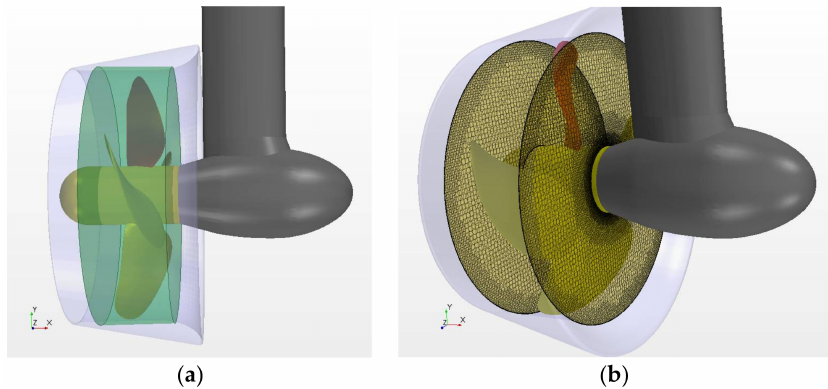
Figure 3. Rotating propeller region and sliding mesh interfaces: ( a ) propeller region; ( b ) sliding